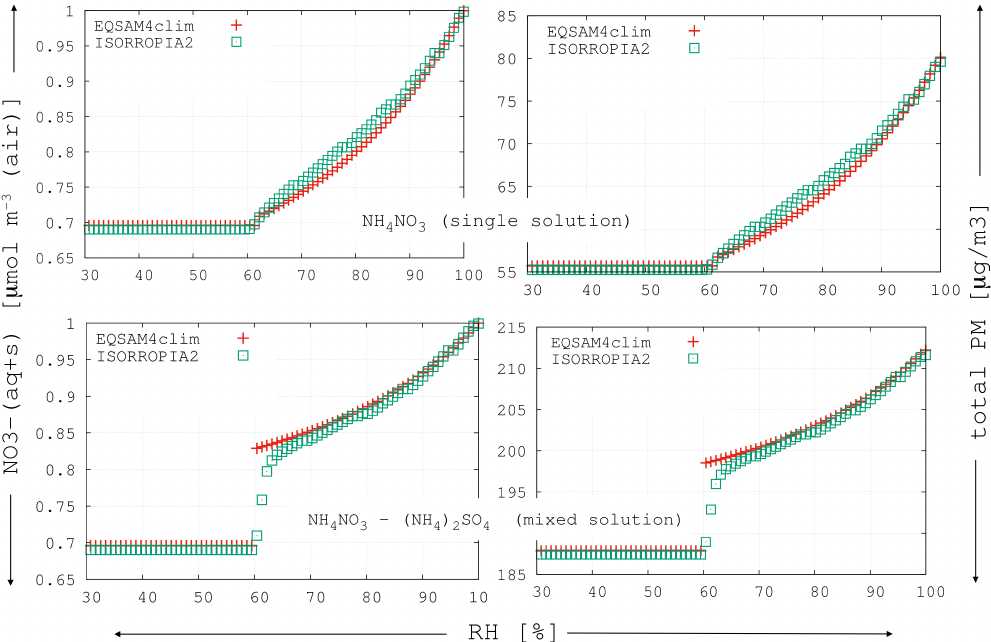
Figure 3. Results of EQSAM4clim (red crosses) and ISORROPIA II (green squares) for two idealised gas–liquid–solid partitioning examples: single solute (binary) solution of pure NH 4 NO 3 (upper panels) and mixed solution of NH 4 NO 3 and (NH 4 ) 2 SO 4 with the concentration of each compound fixed to 1 [ µmolm − 3 ( air ) ] at T = 298 . 15K. The left panels show the NH 4 NO 3 concentration in [ µmolm − 3 ( air ) ] , the right panels show the corresponding particulate mass [ µgm − 3 ( air ) ] . The mixed solution RHD described in Sect. 2.6 has been neglected for EQSAM4clim for this case, since this figure presents only an example for Sects. 2.4 and 2.5 (Sect. 2.6 is considered